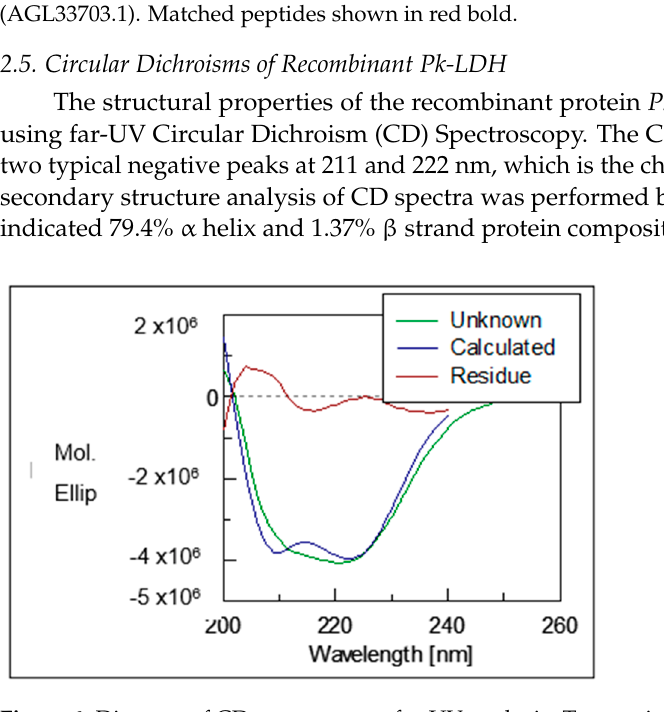
hits. ( b ) Protein sequence coverage of Pk -LDH compared with lactate dehydrohenase from P. knowlesi